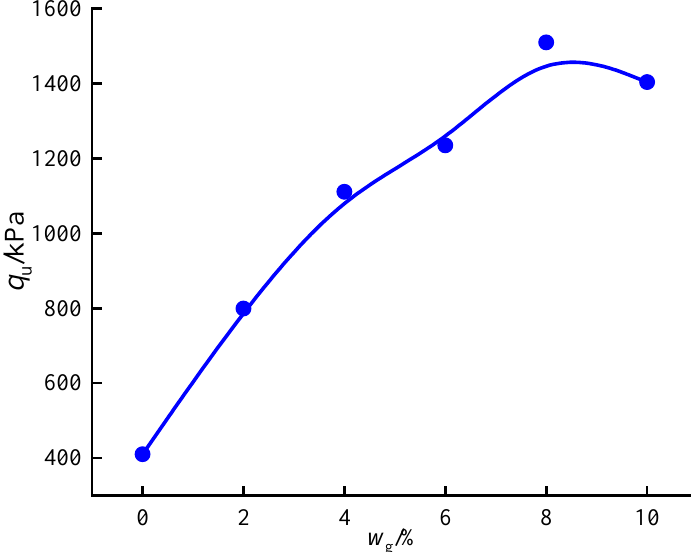
Figure 12. Relationship between subgrade filler strength and curing agent PZ – 1 content.